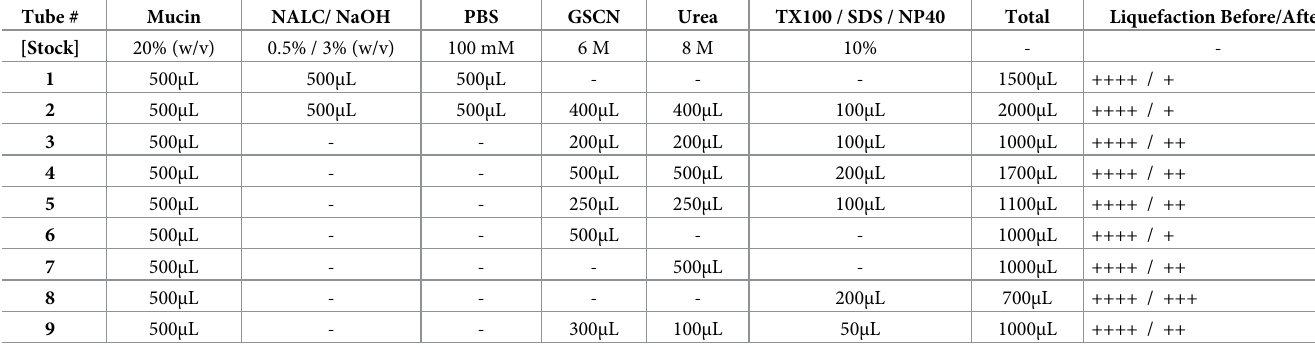
Chemicals and their respective concentration and volumes used to produce different liquefying solutions. Porcine mucin was used as sputum substitute and its viscosity was classified with the naked eye by gentle agitation of the tube. Viscosity of each solution was classified from the most viscous (++++) to less viscous